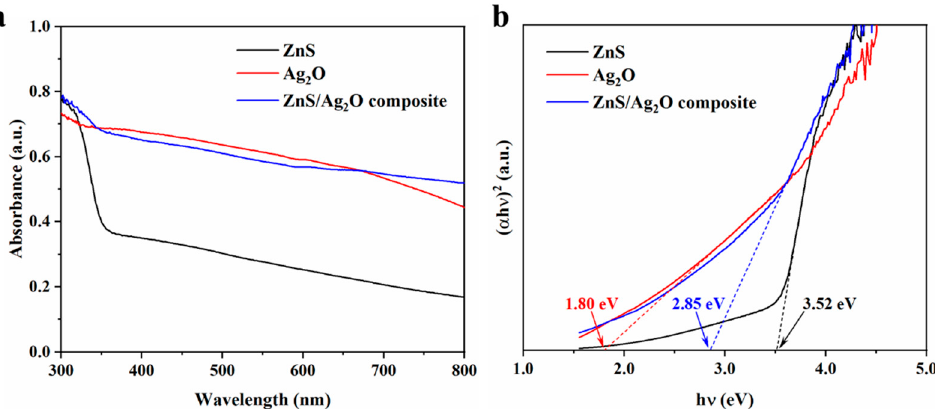
Figure 4. ( a ) UV-Vis DRS spectra and ( b ) Tauc plots of ZnS, Ag 2 O, and ZnS/Ag 2 O composite to show their band gap energy values.